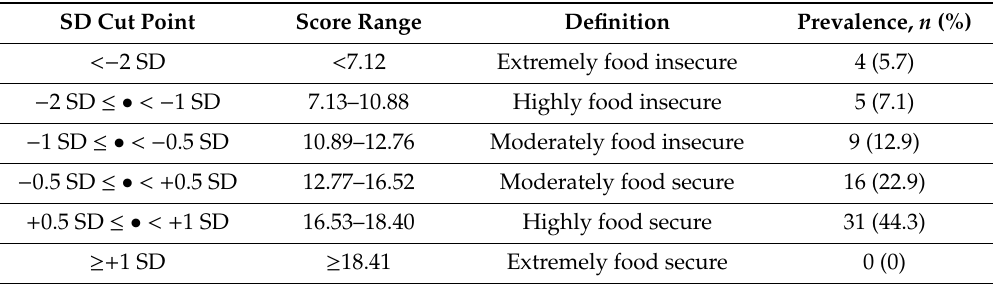
Table 2. Food security classifications using an adapted food security index among infants aged 3–12 months in the cross-sectional study ( n = 70) a .